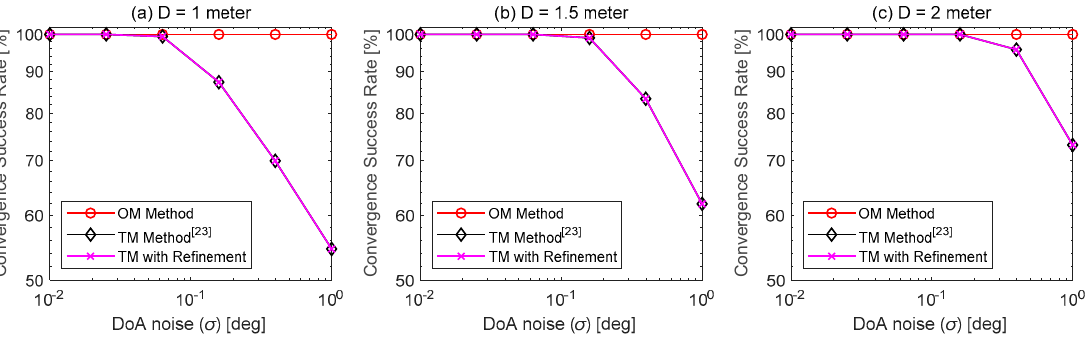
Figure 6. Comparison of the global convergence success rate as a function of the rigid target size D and DoA noise standard deviation 𝜎 . ( a ) 𝐷 = 1 m ; ( b ) 𝐷 = 1.5 m; ( c ) 𝐷 = 2 m . Table 1. Comparison of the positioned RMSEs of the wireless nodes.